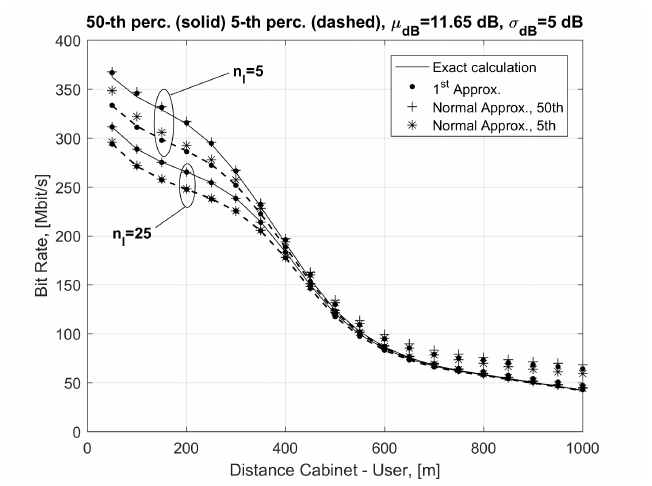
Figure 6. Bit rate vs cabinet-to-user distance for n I = 5, n I = 15 and n I = 25 (50th and 5th percentile).